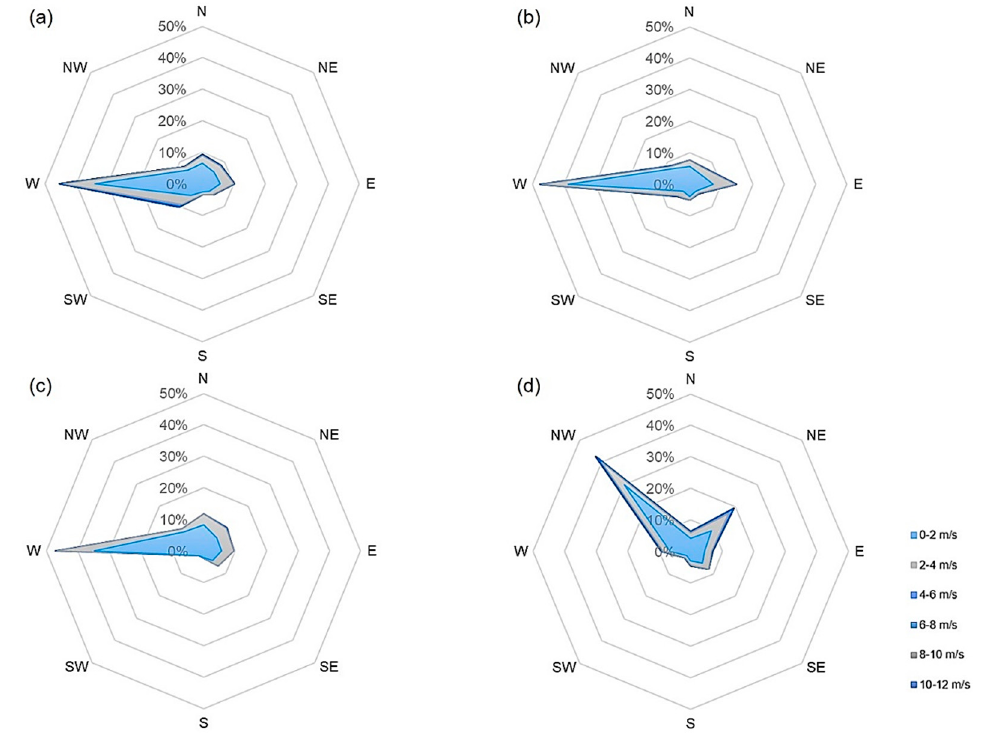
Figure A7. Wind rose from Aero 2 during the measurement campaign in 2019 at the location Emmendingen for the periods ( a ) total: 18.03–14.05, ( b ) pre-flowering: 18.03–09.04, ( c ) main flowering: 09.04–23.04, ( d ) post-flowering: 23.04–14.05.